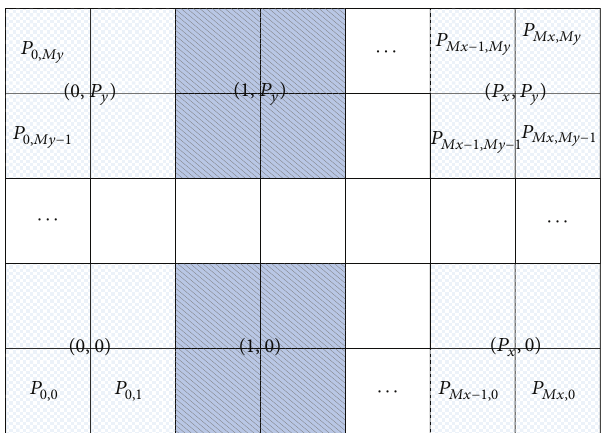
Figure 2: The two-dimensional task distribution model for 2D-